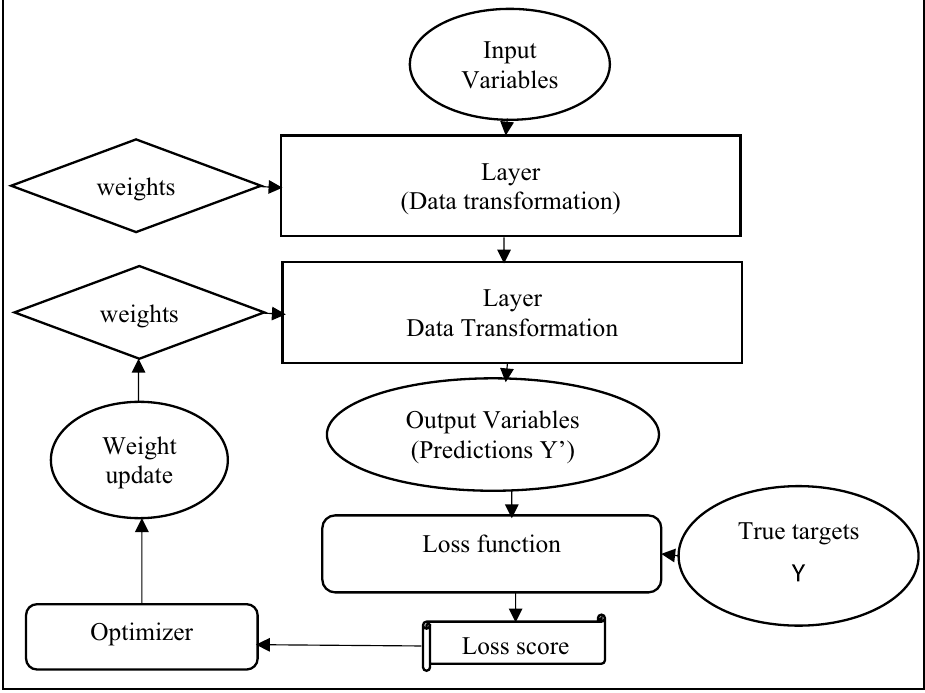
Figure 2. DNN backpropagation algorithm.